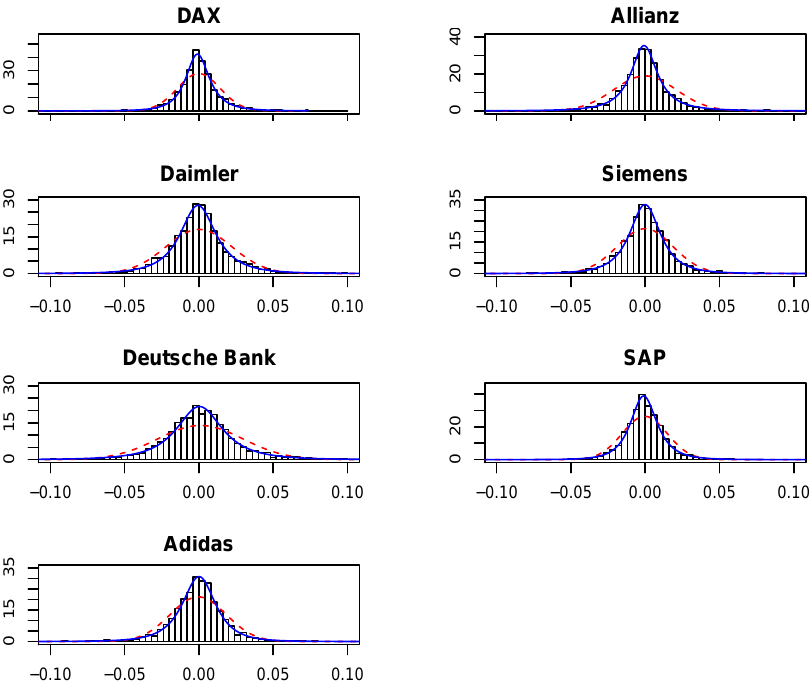
Figure 2: Histograms of the daily log-returns and fitted Gaussian (dashed) and NIG (solid) density with estimated parameters given in Table 1.